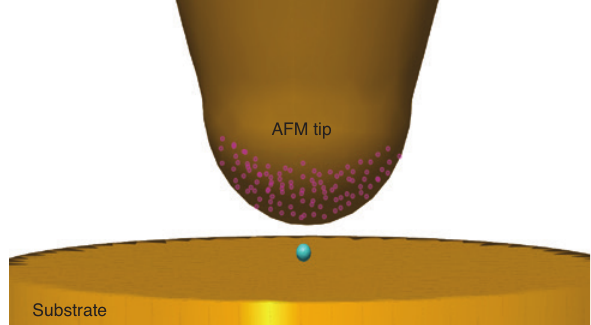
Figure 5: A practical implementation of the extra enhancement. A gold-coated AFM tip can support more than one plasmon resonance [62], similar to Figure 1B. A strong field, localized at the edge of the tip, interacts with a Raman-active molecule (blue) and leads to an enhanced Raman signal. When the tip is decorated (it can as well be called “contaminated”) with auxiliary QEs (purple), of level spacing not close to either the exciting or the Stokes-shifted frequencies, the localized field on the Raman-active molecule remains unchanged. Still, QEs give rise to extra enhancement of the Raman signal from Raman-active molecule(s) due to Fano (interference)